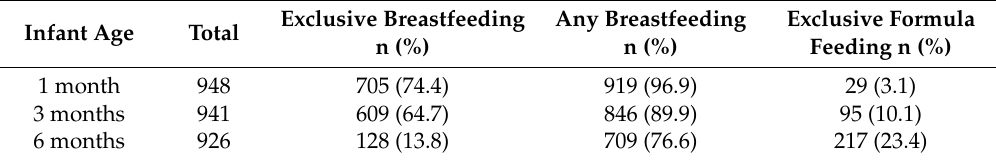
Table 2. Breastfeeding rates during follow-up.